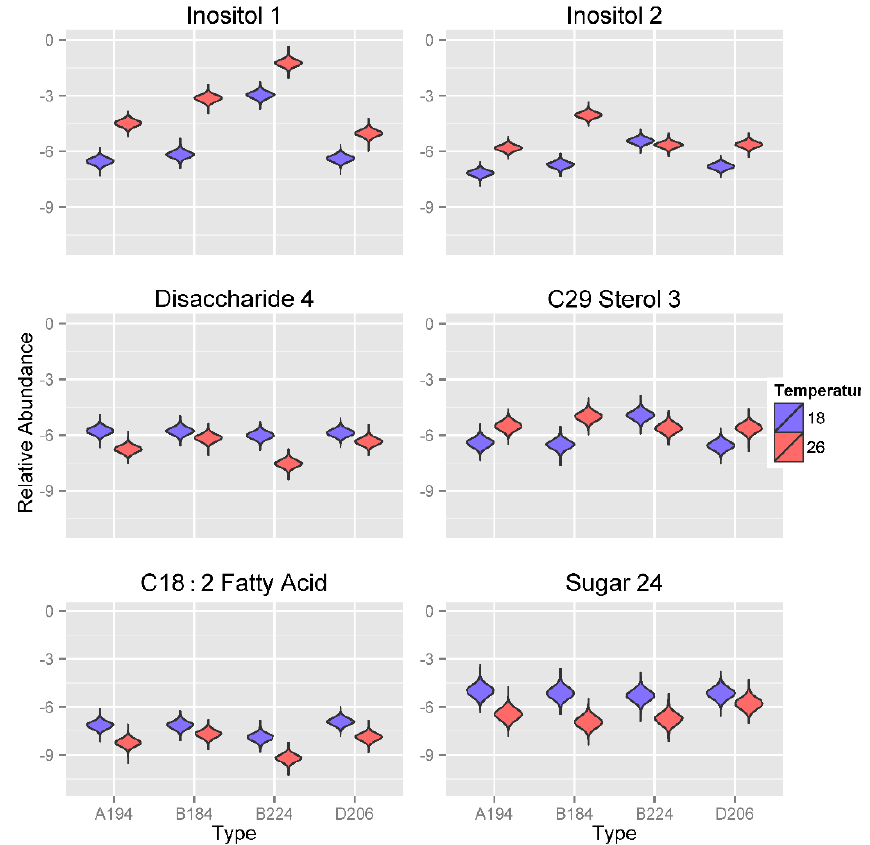
Figure 6. Violin plots showing posterior distributions of estimates of the top six significant predictor metabolites of temperature (°C) for each Symbiodinium type. Metabolite abundance values are Area Under the Curve (AUC)-normalized. Predictor metabolites are sorted from top left to lower right according to their relative importance scores derived from Random Forests analysis. The width of each figure in the violin plot is proportional to the relative frequency of values from the posterior